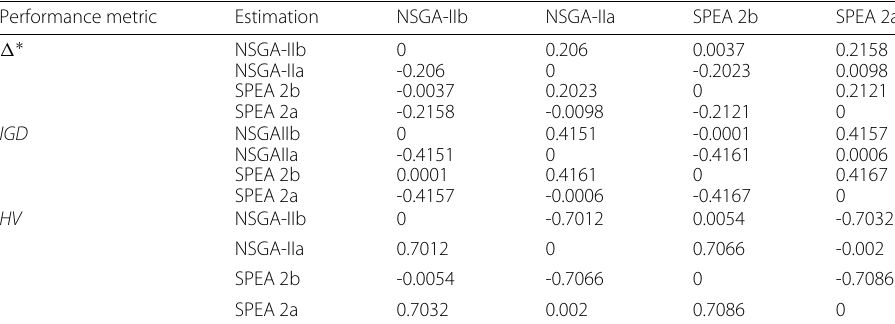
Table 12 Contrast estimation results for the performance metric Performance metric